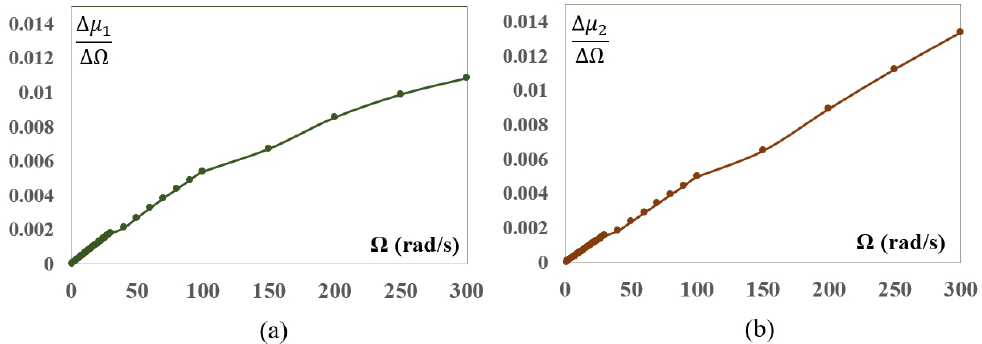
Figure 5. Slope of the curve dimensionless natural frequencies µ vs. rotational speed Ω for: r = 0.26, ξ c = 0.35, α = 0.22 and S L = 85. ( a ) µ 1 and ( b ) µ 2 .